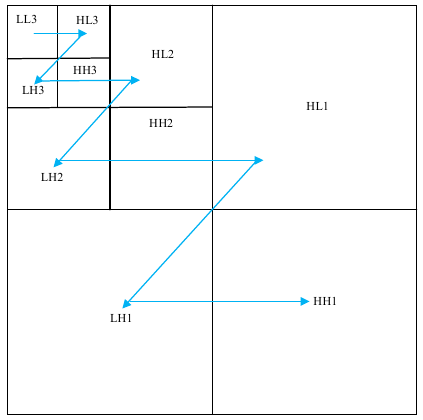
Figure 9. The coefficient scan order of zigzag.